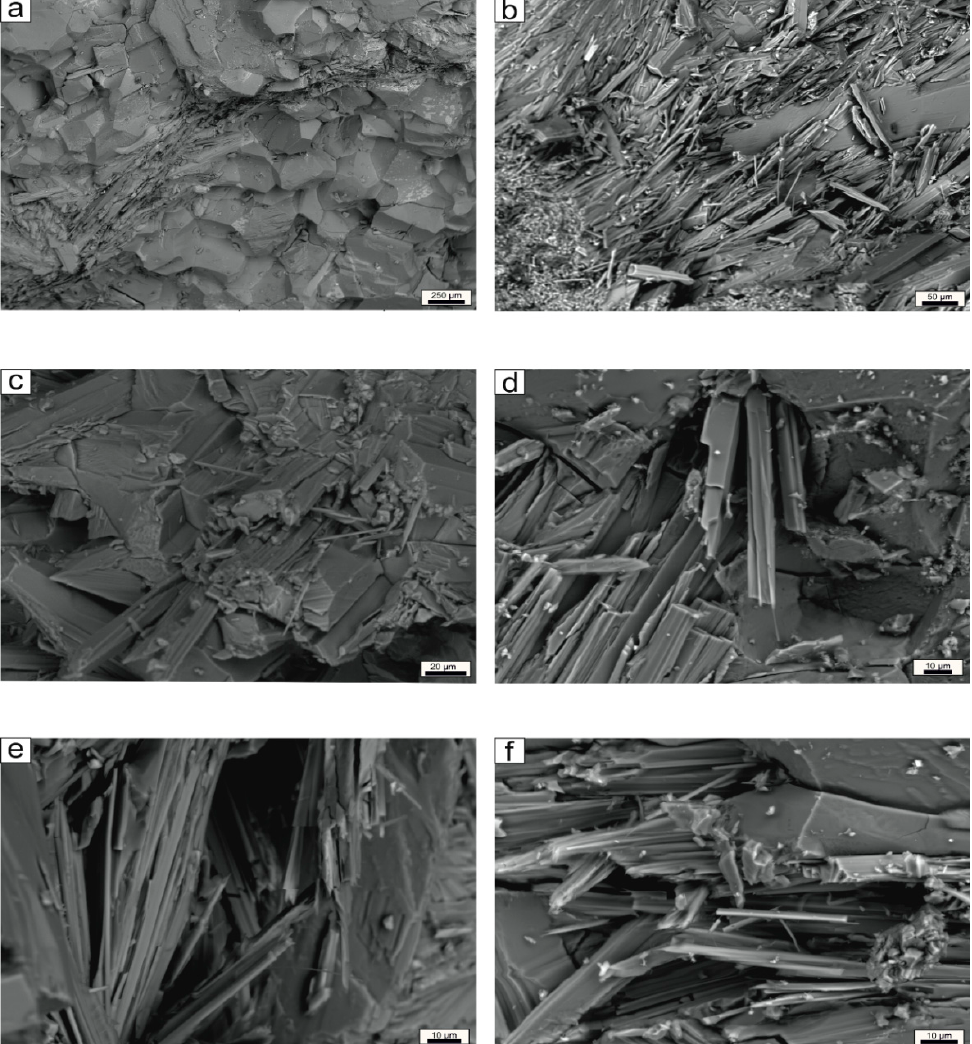
Figure 6. Scanning electron photomicrographs. ( a ) Calcite-rich granoblastic levels cut by tremolite veins; ( b ) Elongated tremolite crystals, sometimes showing radial disposition; ( c ) Tremolite splitting into fibers; ( d ) Tremolite cleavage fragments prone to split; ( e , f ) tremolite fibers whose shape parameters may resemble asbestiform habitus. Mineral symbols after [50].